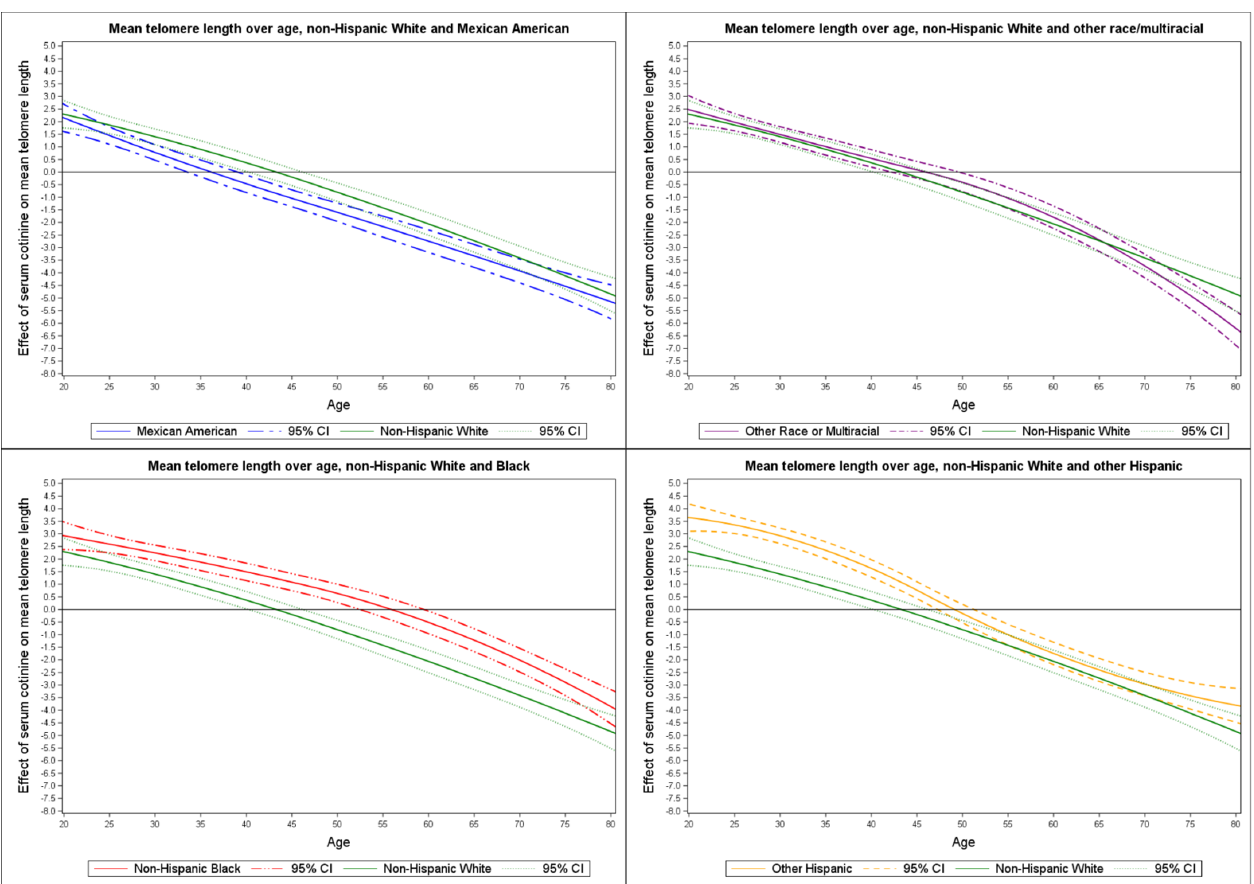
lapped throughout.